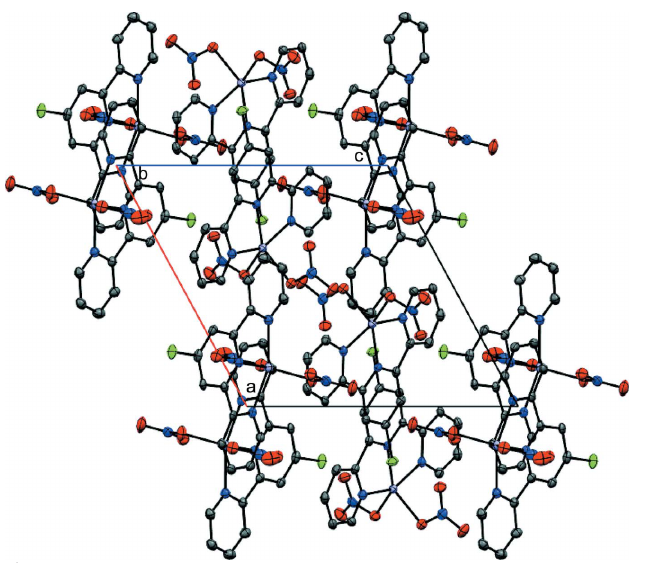
Figure 3 Capped sticks representation of the title molecule showing the Cg (cid:3)(cid:3)(cid:3) Cg distances between pyridine rings; H atoms are omitted for clarity